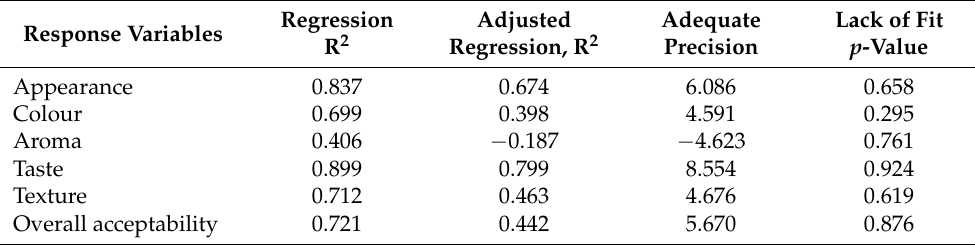
Table 3. Regression coefficients of a quadratic mixture model for boiled instant soup sensory quality.